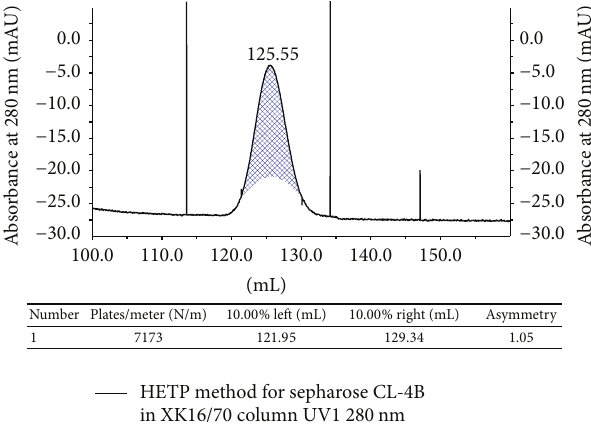
Figure 1: Performance testing of XK16/70 packed with sepharose CL-4B